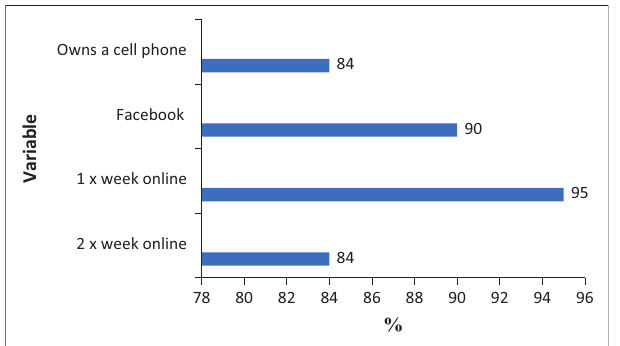
FIGURE 3: Forms of TABLE 1: Frequency of being bullied by gender and intervals.